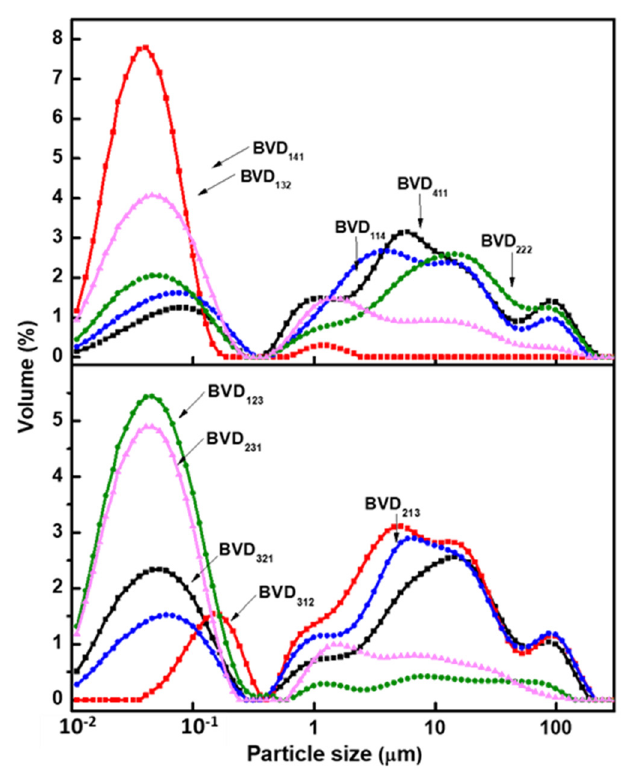
Figure 10. Particle size distribution curves of fluorescent dispersions synthesized with BV.